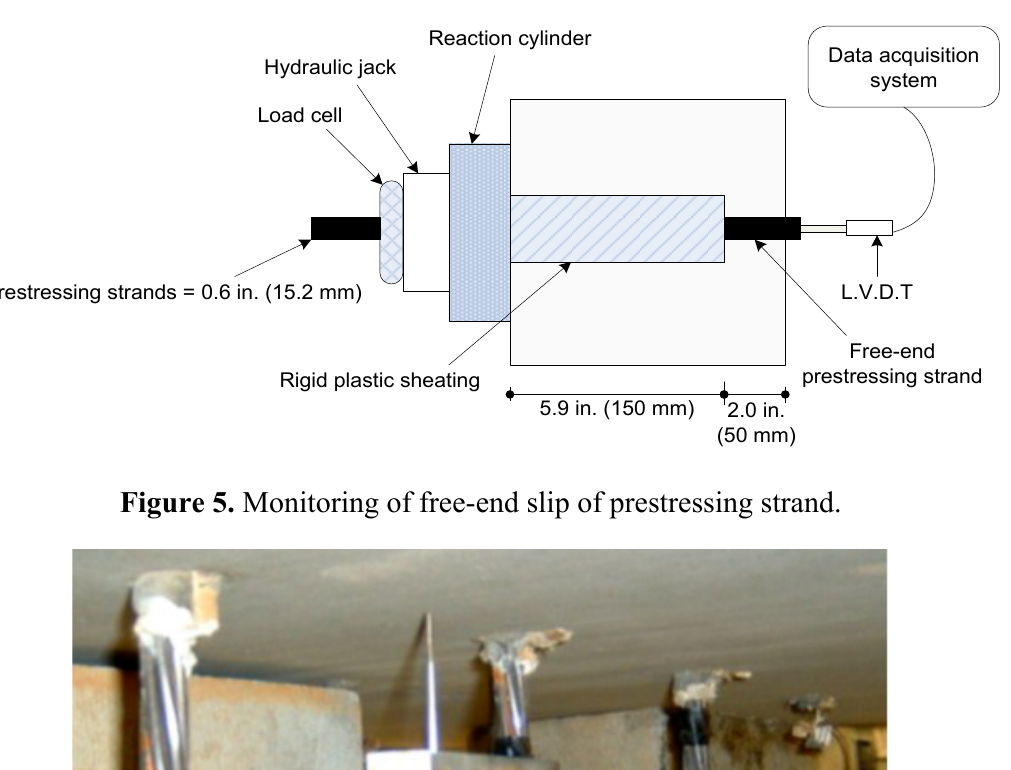
Figure 4. Schematic of pull-out testing arrangement.